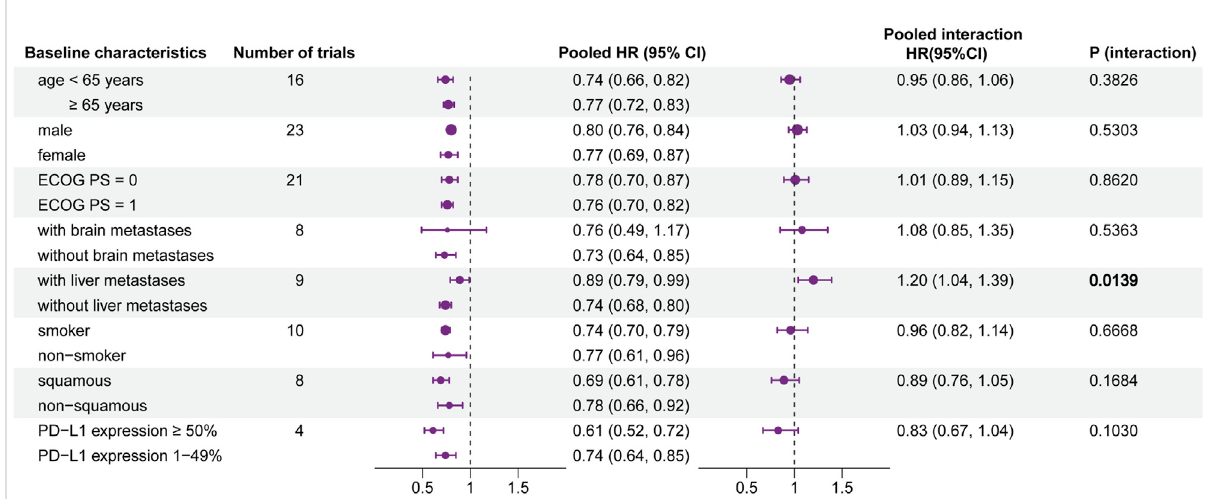
FIGURE 3 Forest plot of hazard ratios for overall survival according to baseline characteristics. Left forest plot: hazard ratios of overall survival for patients assigned to the intervention group, compared with those assigned to the control group, strati fi ed by each baseline characteristic. Right forest plot: interaction between immunotherapy ef fi cacy and each baseline